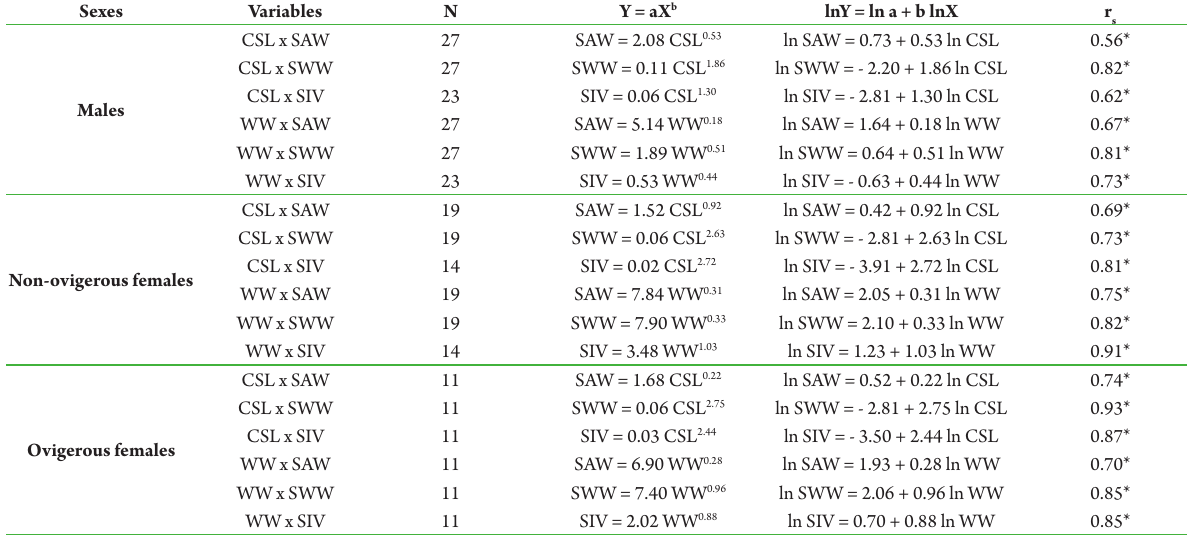
= Spearman correlation s